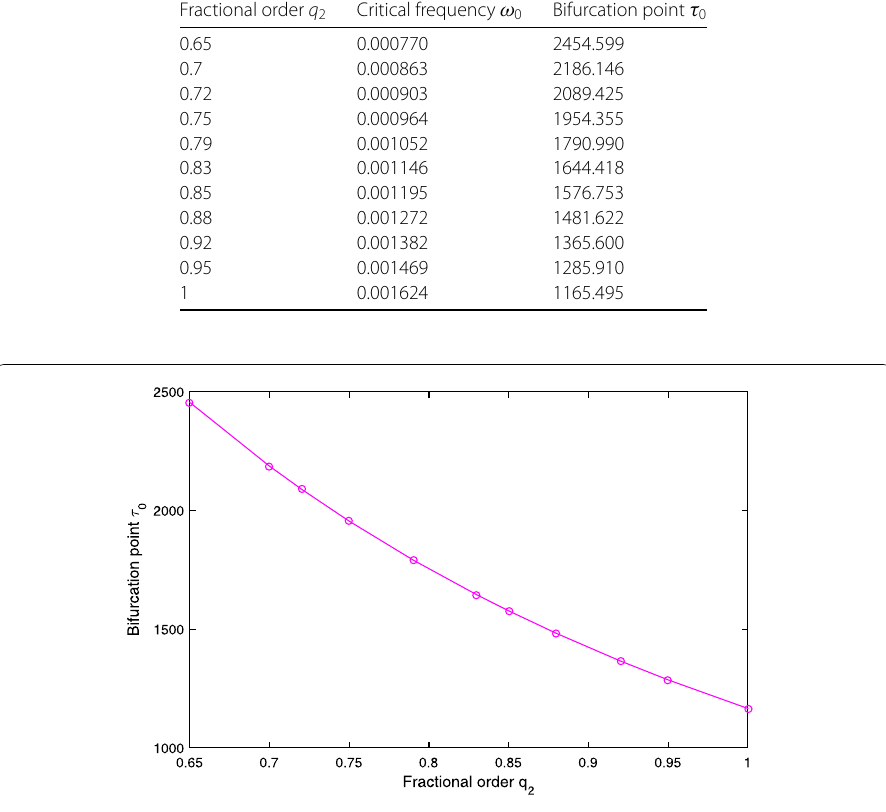
Figure 9 Graph of bifurcation point τ 0 versus the order q 2 for system (29) when q 1 is fixed at 0.92